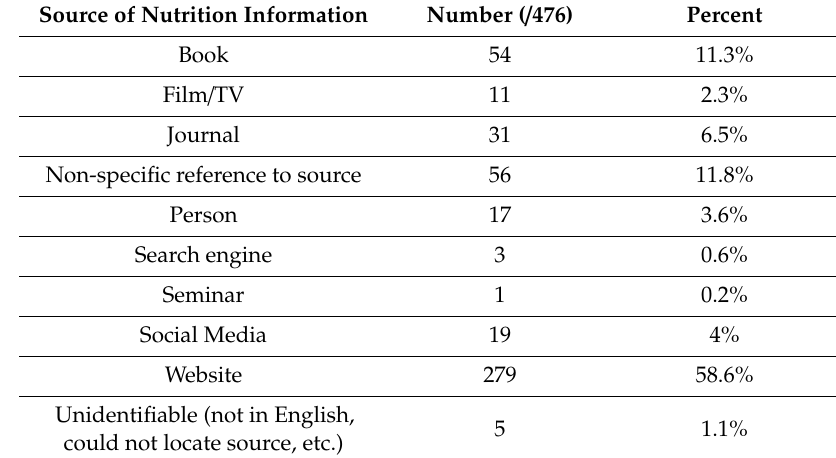
Table A5. Results for sources of nutrition information.